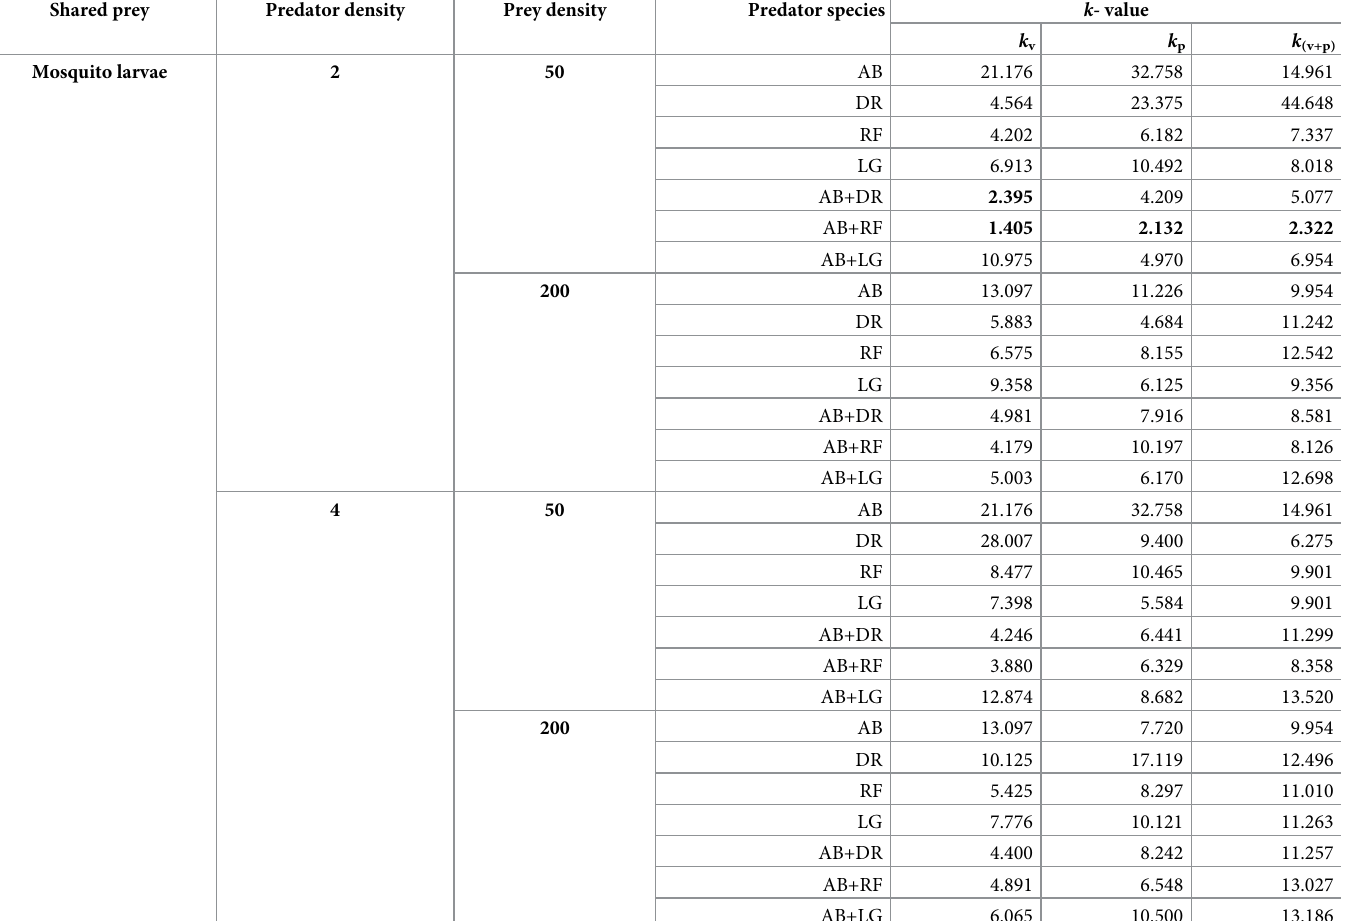
Table 3. The results of t-test using mosquito larvae as shared prey in the IGP system with different habitat conditions (v–vegetation, p–pebbles and v+p—vegetation and pebbles) against open condition. Shared